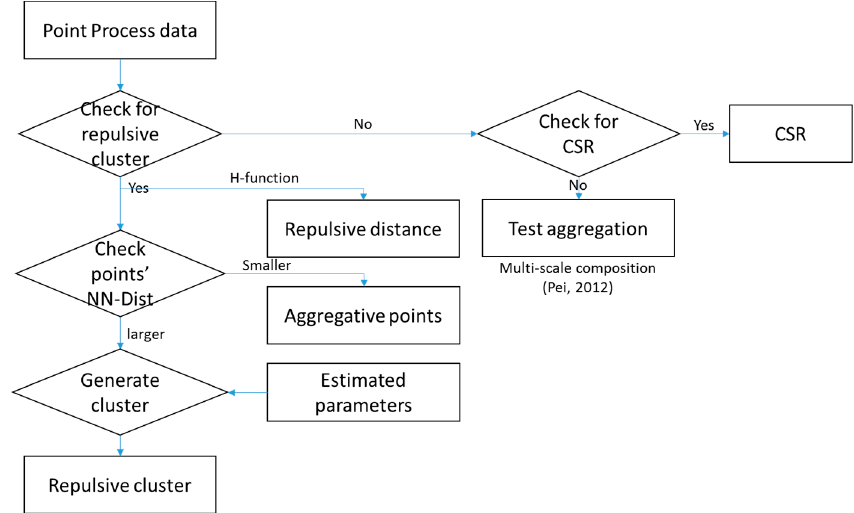
Figure 4. Process of decomposing repulsive clusters from the point process.